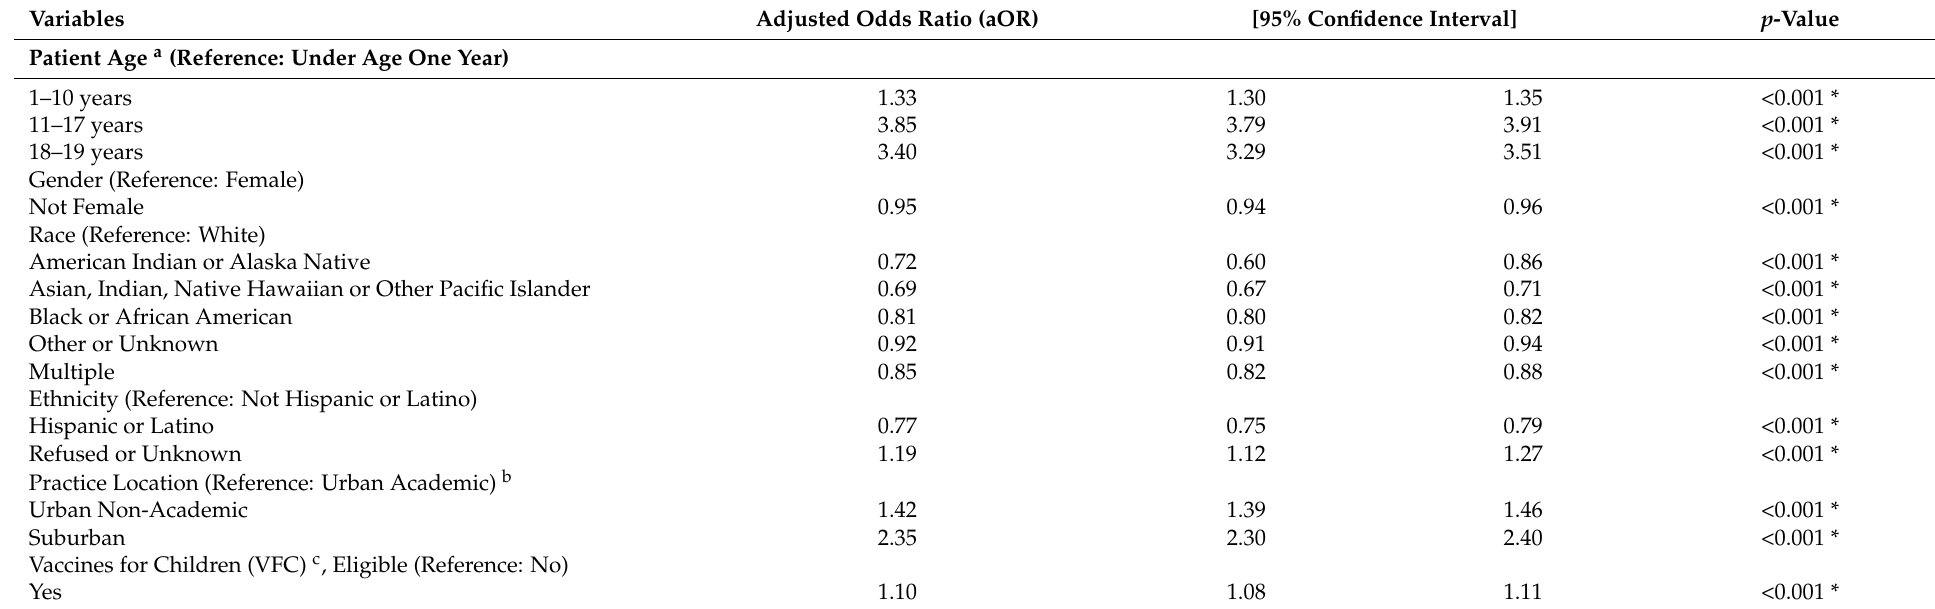
Table 3. Multivariable logistic regression results for documentation of at least one refusal marker when vaccination was indicated (n =